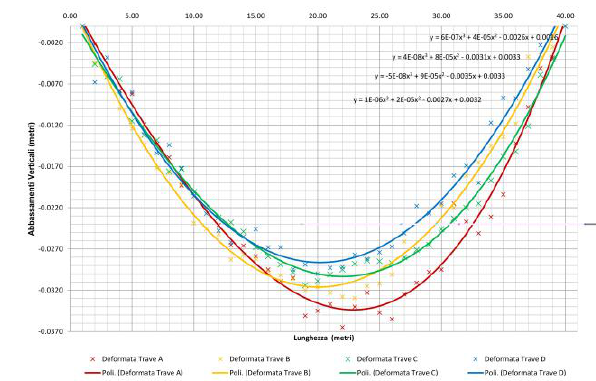
Figure 07. Relative displacement interpolation